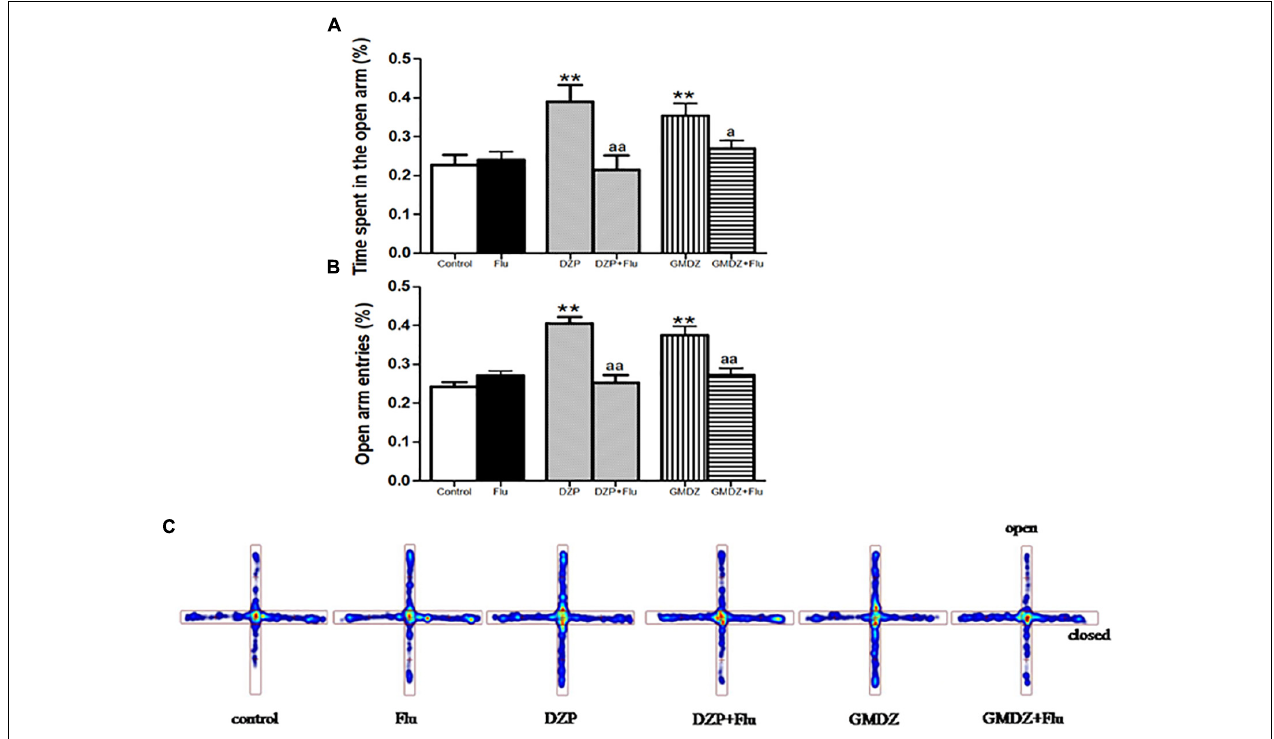
FIGURE 3 | Effects of receptor antagonists on anxiolytic-like effect of GMDZ in EPM test. (A) Effect of Flu on the percentage of time spent in open arms. (B) Effect of Flu on the percent of open arms entries. (C) Representative heat map analysis of one animal in each group. Value are represented as mean ± SEM ( n = 12). ∗∗ P < 0.01 vs. control group; a P < 0.05 or aa P < 0.01 treatment vs. antagonist (interaction effect). Two-way ANOVA with Bonferroni post hoc